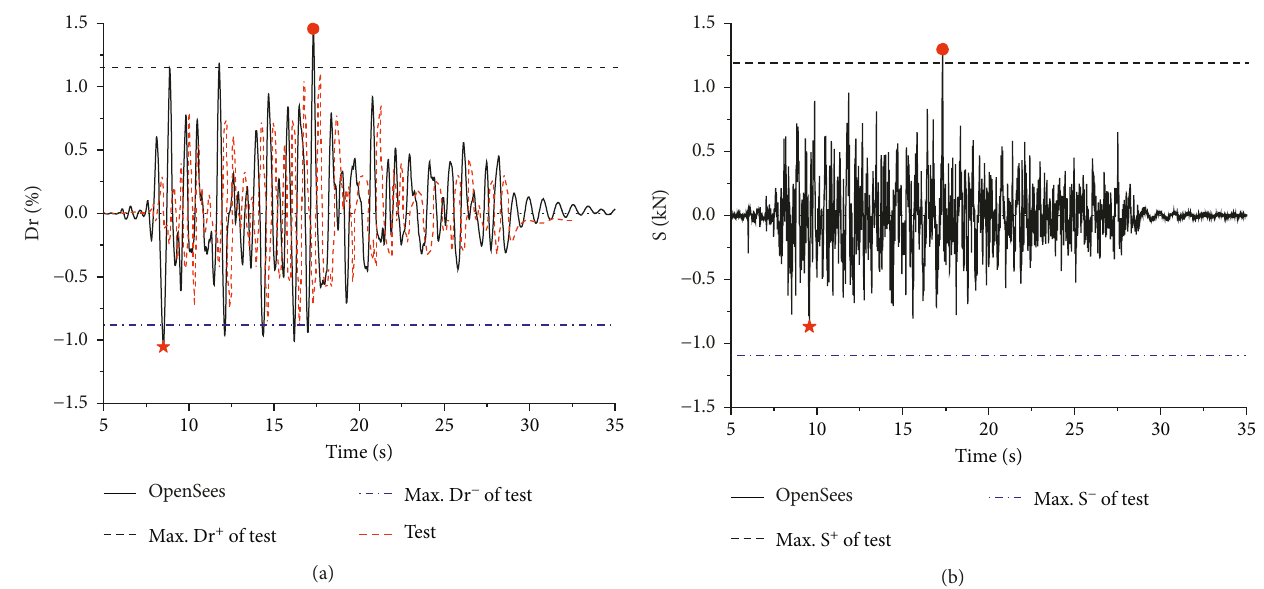
Figure 7: Comparison of analytic model and test for specimen ST 1-c. (a) Drift ratio. (b) Strength.